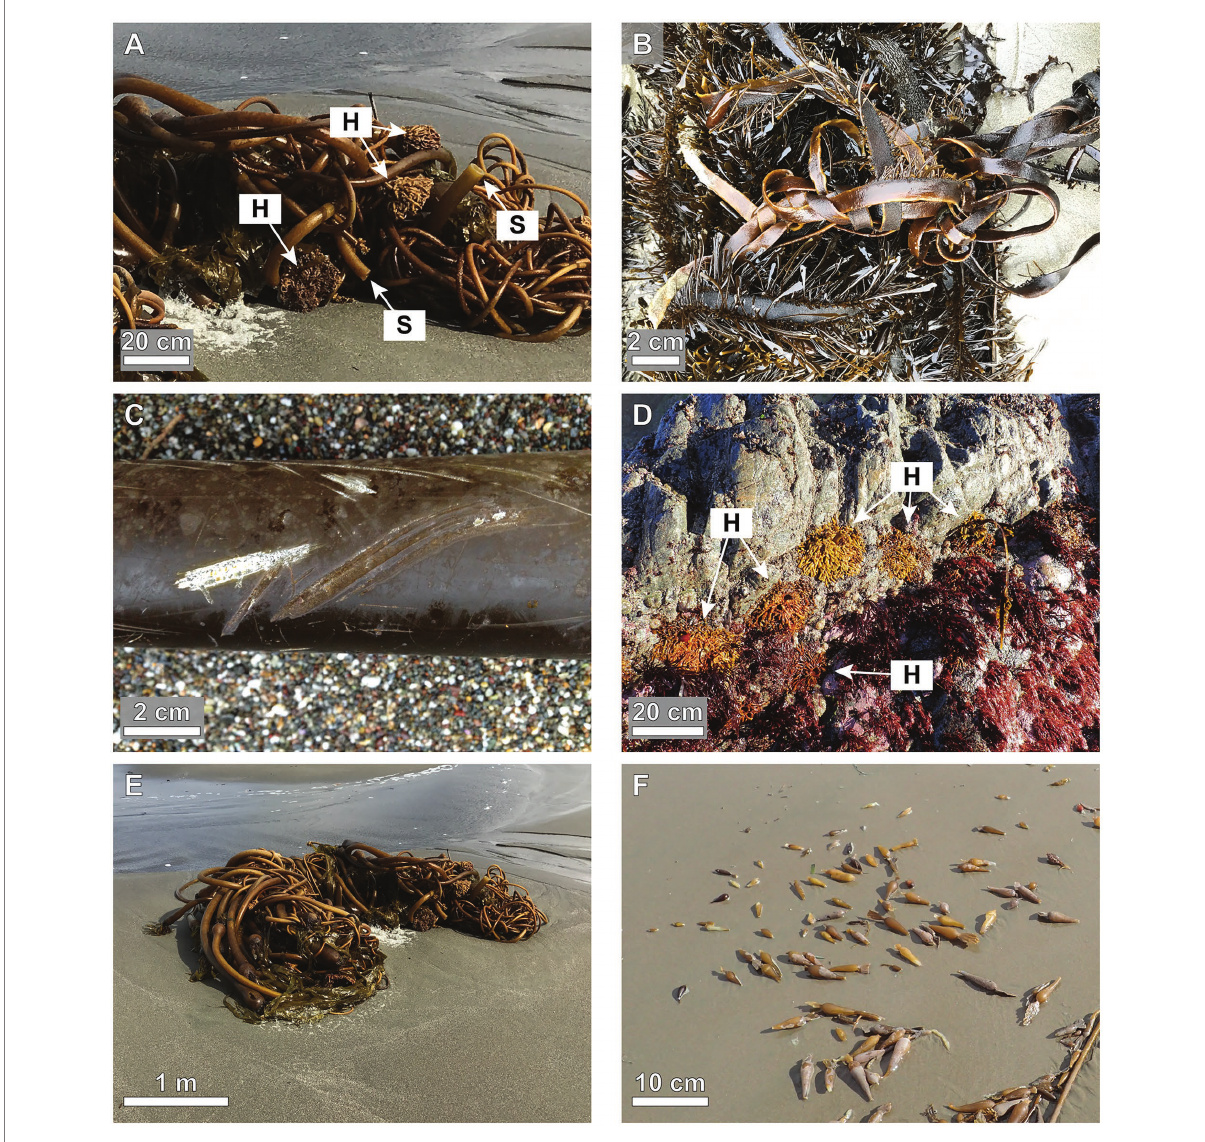
FIGURE 1 Examples of hydrodynamic damage to macroalgae. (A) Kelp, Nereocystis leutkeana washed up on the shore, showing broken stipes (S) and detached holdfasts (H). (B) Tangled, abraded fronds of kelp, Egregia menziesii . (C) Abrasions on the stipe of a N. leutkeana . (D) Holdfasts of E. menziesii on a rocky shore after stipes have broken away. (E) Beach wrack illustrating the loss of biomass from kelp forests due to hydrodynamic forces on herbivore-damaged N. leutkeana (Koehl and Wainwright, 1977). (F) Gas-filled floats (pneumatocysts) ripped off at their narrow stems from fronds of E. menziesii by moving water and washed